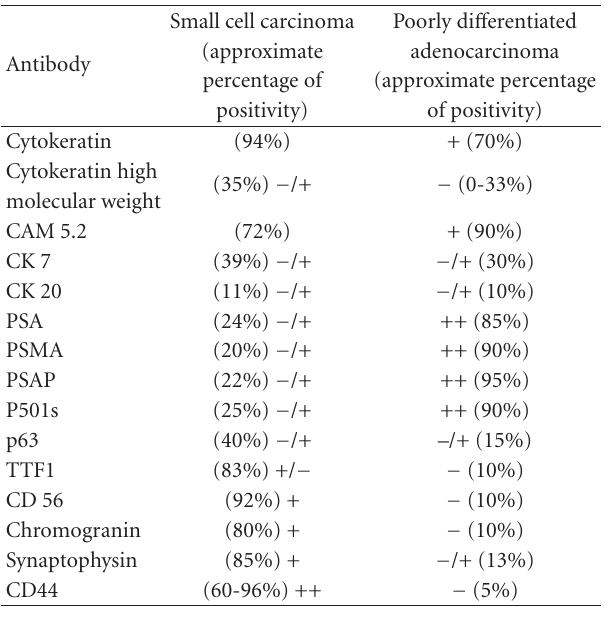
Table 1: Immunohistochemical findings of small cell carcinoma of the prostate compared with conventional high-grade adenocarcino- mas [6, 8, 10, 17, 20, 30–35].